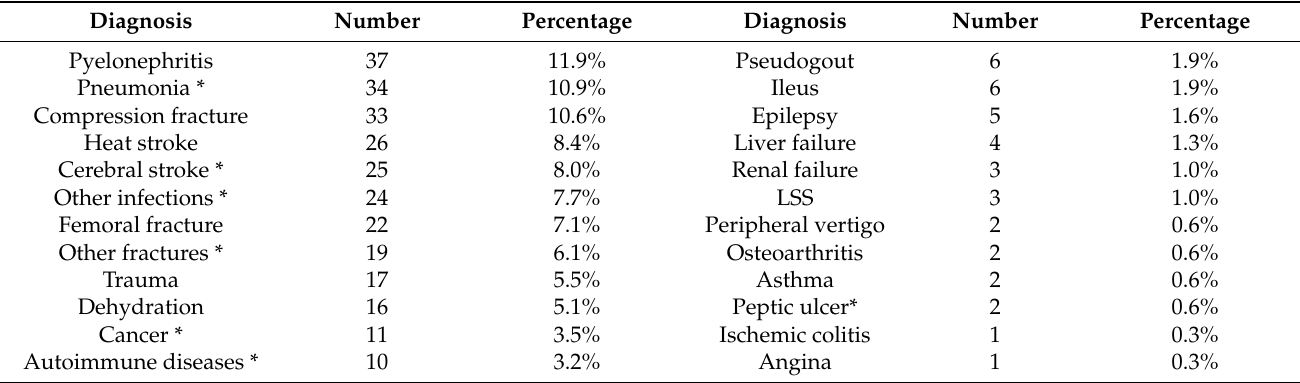
Table 4. Frequency of readmission by